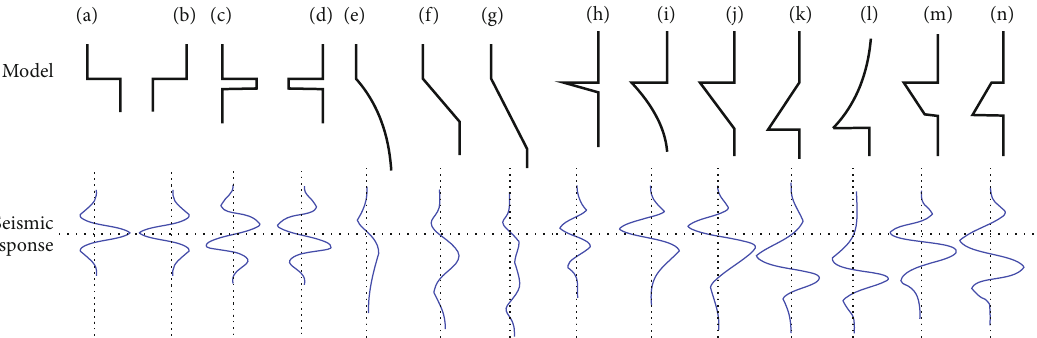
Figure 3: Re fl ectivity models (upper row) and their seismic response obtained by the convolution with zero-phase Ricker wavelet (lower row) [8], p. 237.